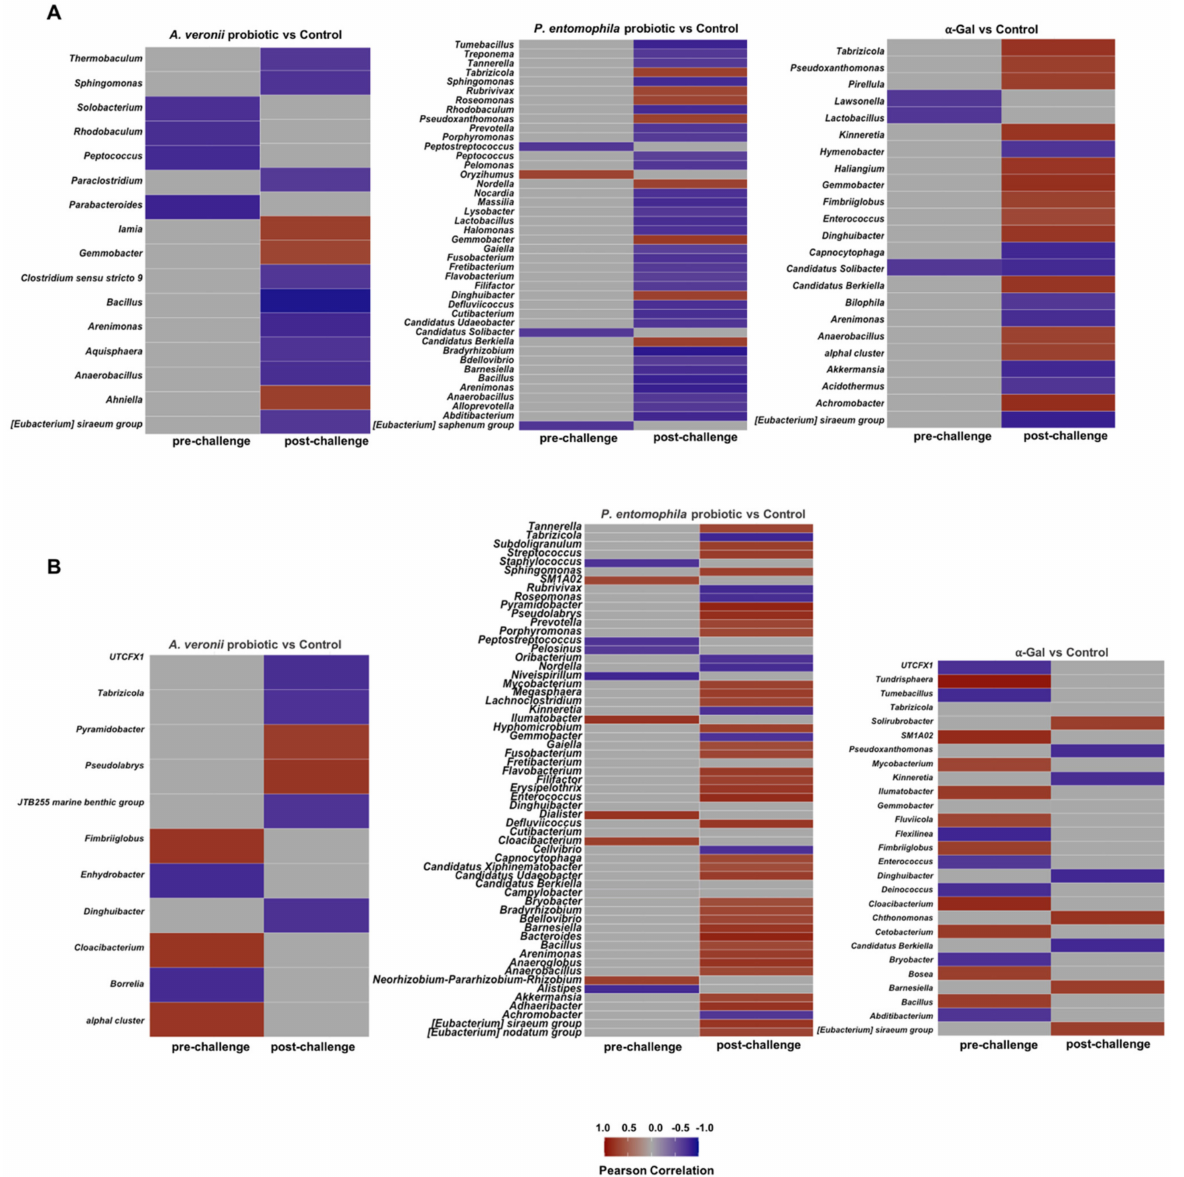
Figure 9. Correlation between zebrafish gut microbiota and antibody response. Heatmaps of the significantly correlated taxa with ( A ) anti- α -Gal and ( B ) anti-P22 IgM titers for each experimental group and at each stage (pre-challenge, post-challenge). Pearson correlations between zebrafish gut microbiota and anti- α -Gal and P22 IgM antibody titers were calculated with ALDEx2, using the aldex.corr function analysis, as implemented in